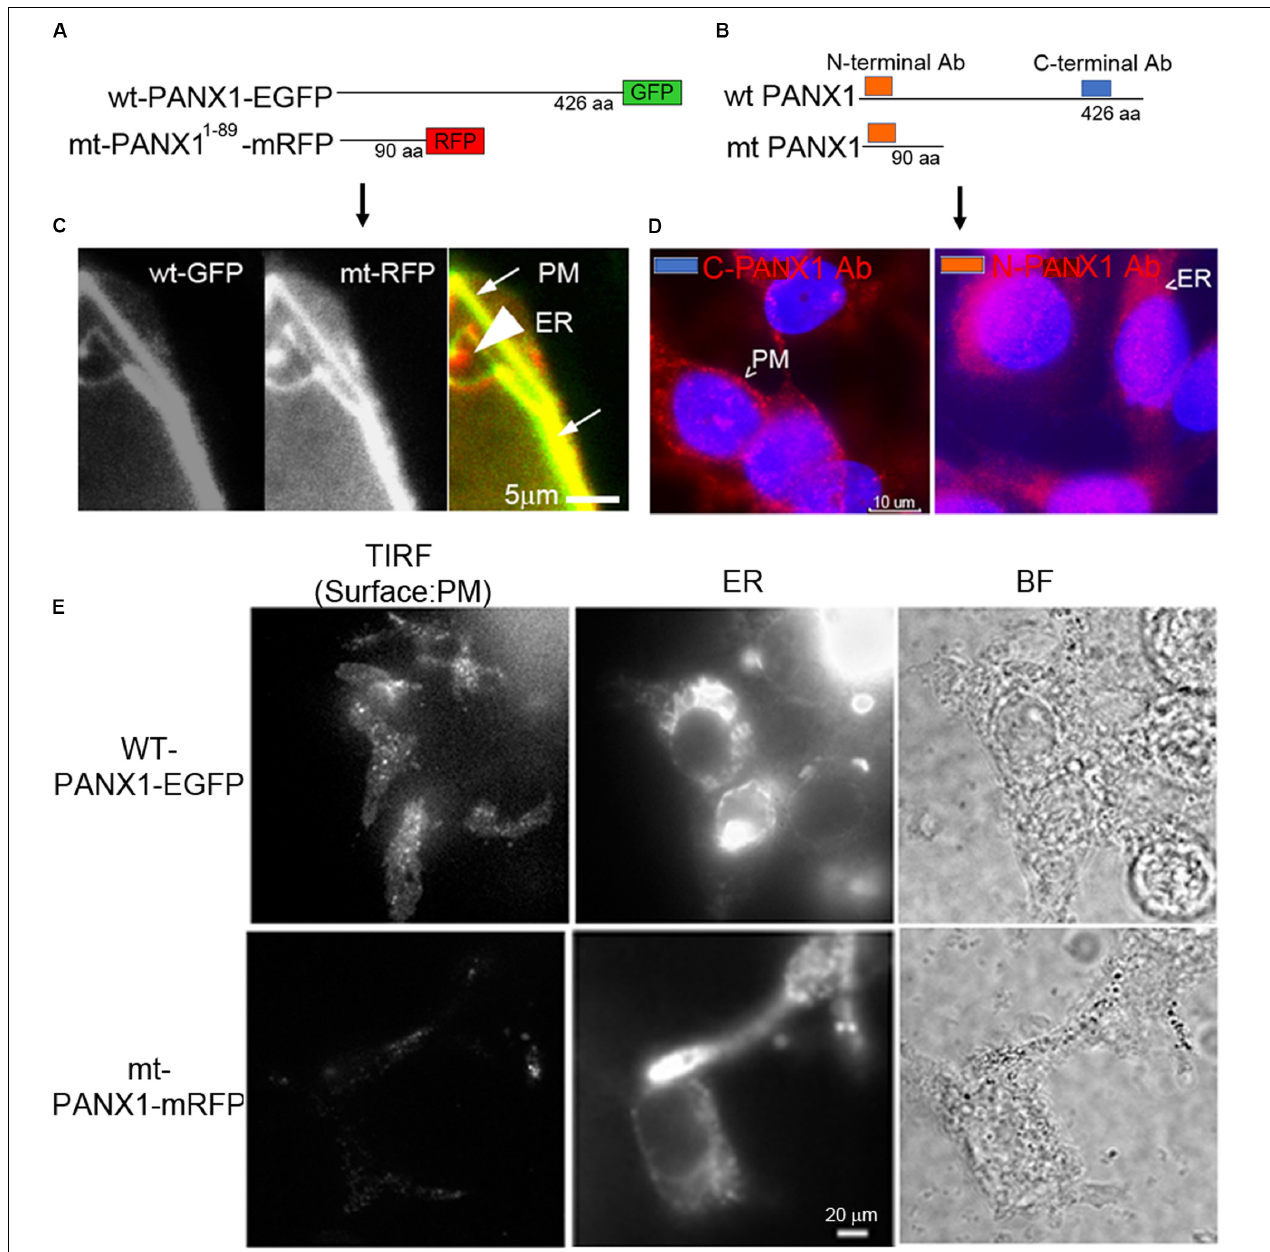
FIGURE 5 | Localization of PANX1. (A,B) Schematic of fluorescent WT and mt PANX1 constructs (A) and the N and C-terminal epitopes recognized by anti-PANX1 antibodies (Ab) (B) . (C) Localization of WT PANX1-EGFP and mt PANX1-mRFP in transfected HEK cells. (D) Localization of endogenous PANX1 in PC-3 cells using N- or C-terminal specific Abs. Nuclear DAPI stain is depicted as blue. (E) TIRF imaging on HEK cells transfected by WT PANX1-EGFP or mt PANX1-mRFP constructs. WT PANX1-EGFP localizes in the PM and the ER, while mt PANX1-mRFP only in the